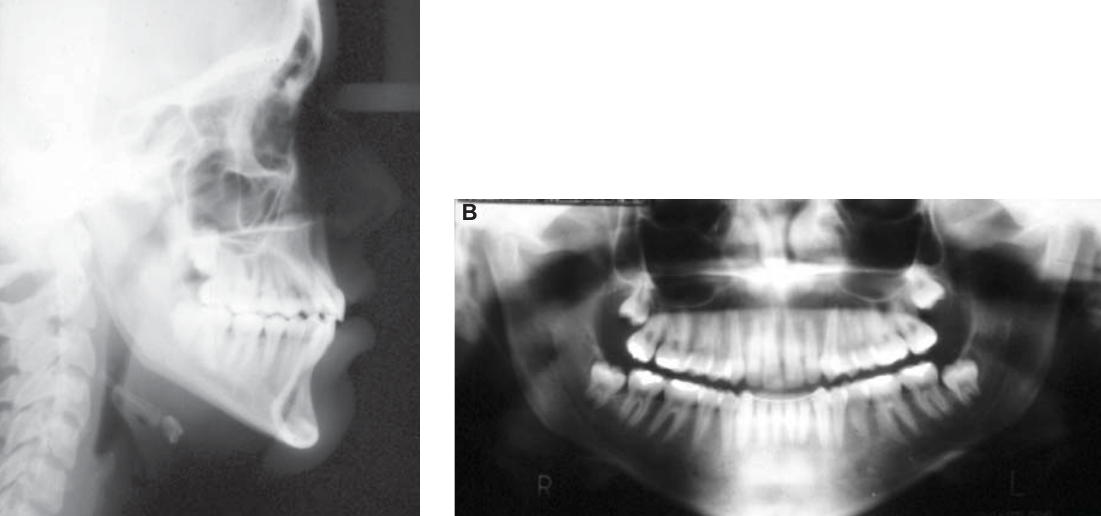
Figure 6- Final lateral cephalograms (A) and panoramic radiograph